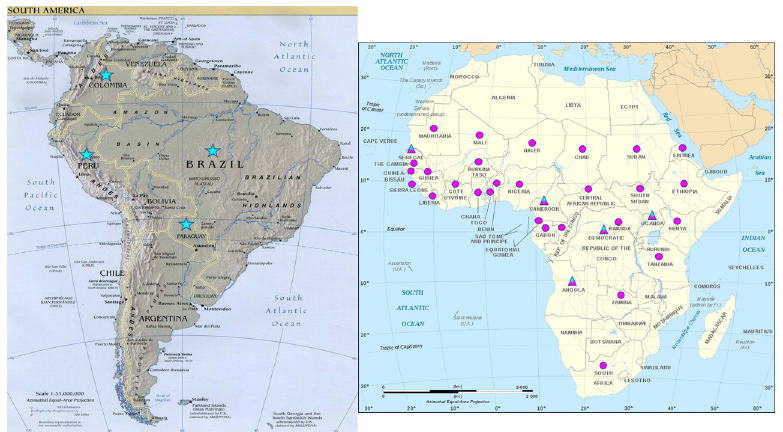
Fig 1. Global Map of Countries Participating in 2018 and 2019 Yellow Fever Proficiency Testing Exercises. Countries participating in 2018 YF PT only (blue star)–Brazil, Colombia, Paraguay, Peru. Countries participating in 2019 YF PT only (pink circle)–Benin, Burkina Faso, Central African Republic, Chad, Cote d’Ivoire, Equatorial Guinea, Eritrea, Ethiopia, Gabon, Ghana, Guinea, Guinea-Bissau, Kenya, Liberia, Mali, Mauritania, Niger, Nigeria, Republic of the Congo, Rwanda, Sierra Leone, South Africa, South Sudan, Sudan, Tanzania, The Gambia, Togo, Zambia. Countries participating in both 2018 and 2019 YF PT (blue/pink triangle)–Angola, Cameroon, Democratic Republic of the Congo, Senegal, Uganda. Abbreviations: YF–yellow fever; PT–proficiency testing Website link to South America map: